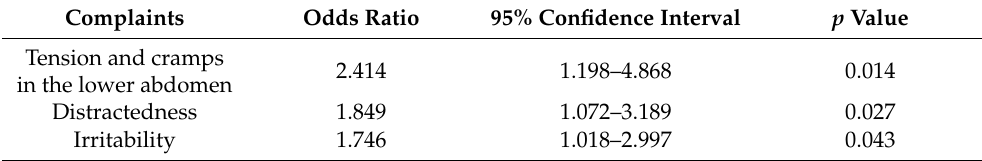
Table 3. Relationship between event experiences and common complaints in